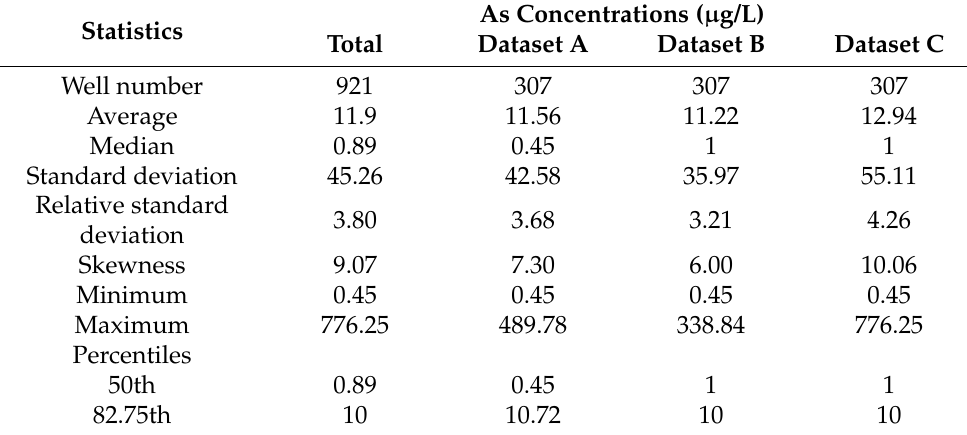
Table 2. Descriptive statistics of the monitored As concentrations in the Lanyang